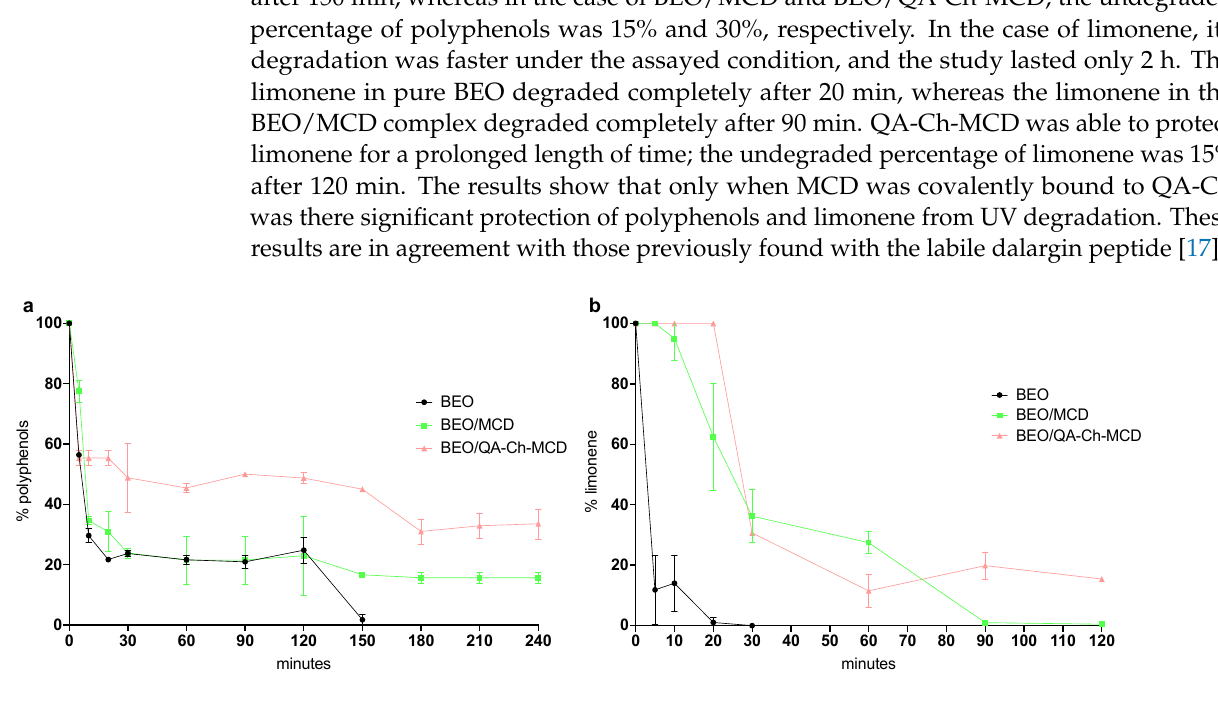
Figure 2. Polyphenol ( a ) or limonene ( b ) stability in SGF under UV irradiation. Means ± SD ( n = 3) .